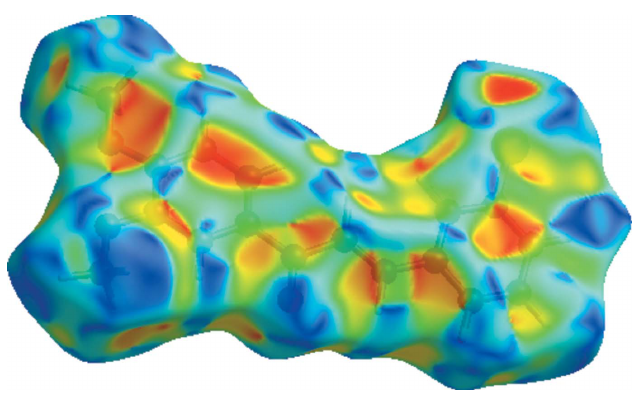
Figure 4 Hirshfeld surface of the title complex plotted over shape-index.